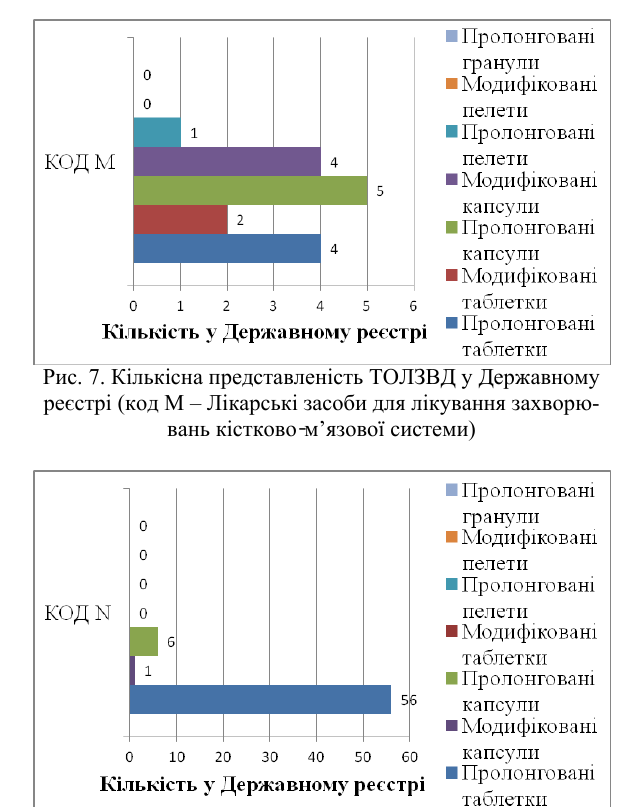
Рис. 8. Кількісна представленість ТОЛЗВД у Державному реєстрі (код N – Лікарські засоби для лікування захворювань нервової